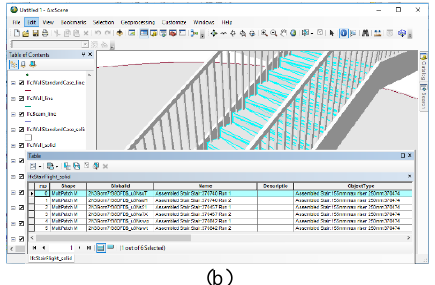
Figure 9. BIM model in ArcGIS platform ((a) 3D model in ArcScene which show the misallocated element flat roof into slab element, (b) the querying process of the StairFlight